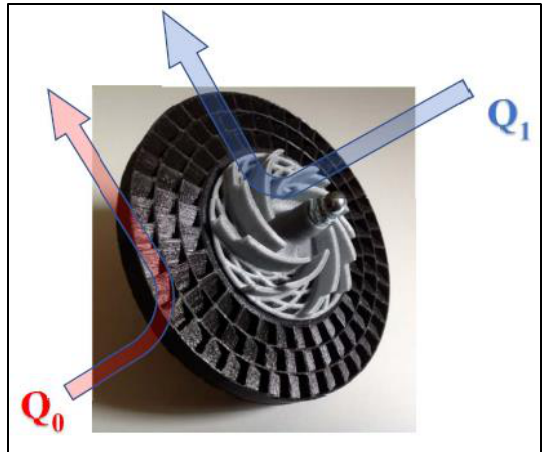
Figure 32. Micromodel of an experimental rotor with an axial mesh